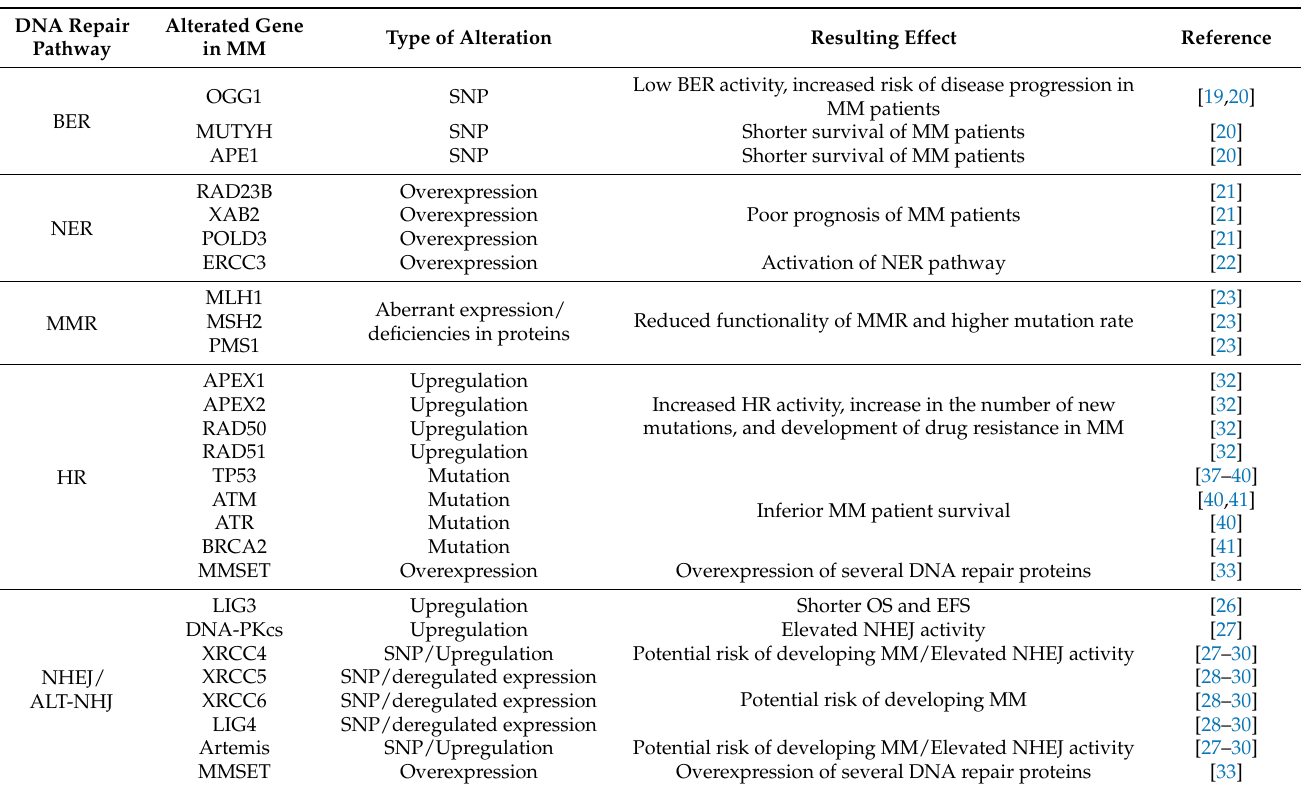
Table 1. Crucial genes of the DNA damage response found deregulated in MM. DNA Repair